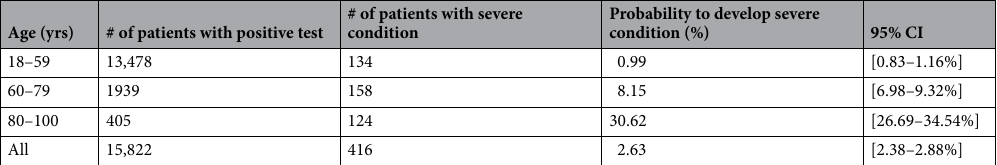
Table 2. Age stratification of risk for deterioration in SARS-CoV-2-positive patients.